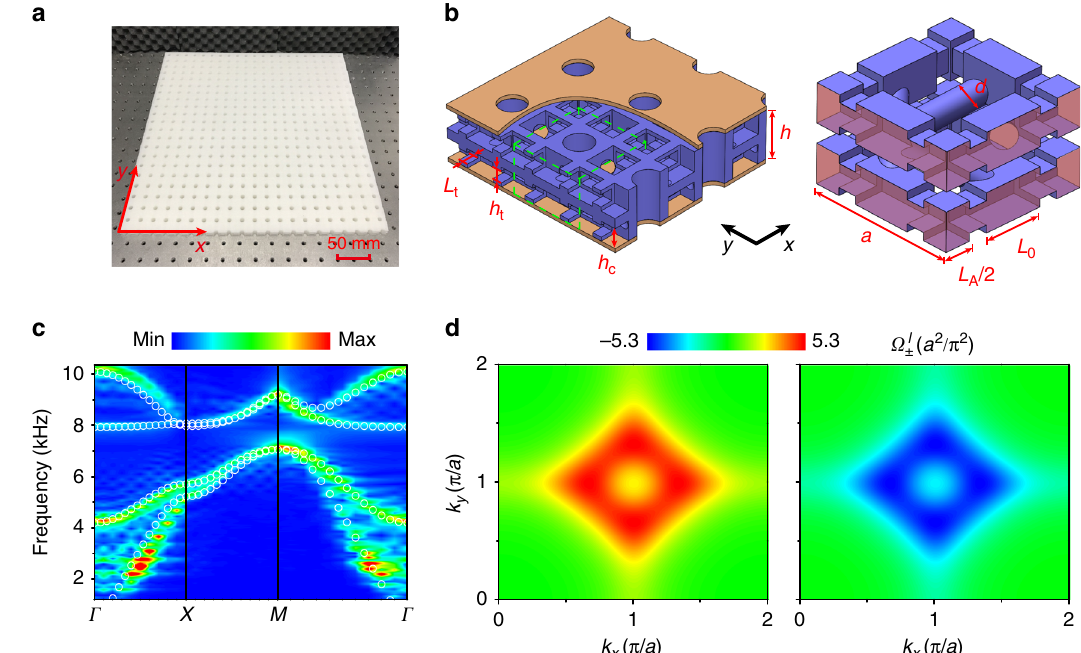
Fig. 2 Acoustic spin-Chern insulator and bulk properties. a A photo of the bilayer sample. The cylindrical holes are indeed for cost savings and have no effect on the propagation of acoustic waves in the PC. b Left panel: magni fi ed side view of the sample, which contains the whole-cell (up-edge) and half-cell (down-edge) boundaries along the x direction. Air fi lls the inside of the bilayer structure (blue color) between two rigid plates (brown color). Right panel: the unit cell of the sample, corresponding to the green dotted box in the left panel. The blue (pink) areas represent the rigid (periodic) boundaries. c The bulk band structure of the lowest four modes along high symmetry lines. The color maps denote the measured data, and the white circles represent the simulated results. d The calculated Berry curvatures of the spin-up (left) and -down (right) projection sectors for the lower two bands.